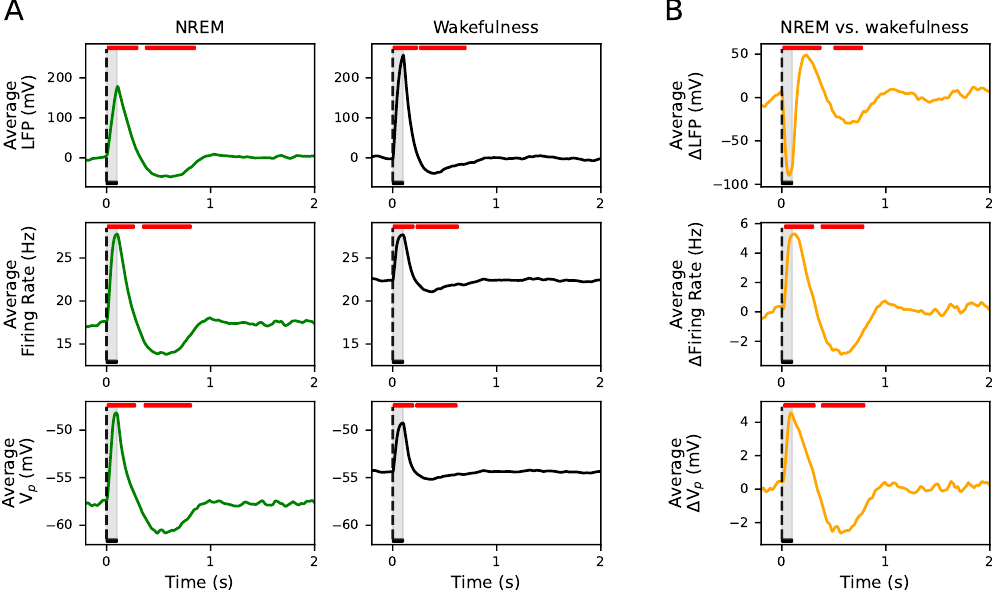
Figure 3. Evoked response in the one-cortical-column model. ( A ) Average LFP, firing rate and V p across 500 simulations for NREM sleep (left column) and wakefulness (right column). Red horizontal bars show the location and length of significant t-cluster statistics when comparing the poststimulus versus the prestimulus intervals. In all signals, responses to the external stimulus consist of one positive and one negative significant deflection. The positive ( p < 0.0006) and negative ( p < 0.001) deflections are significant in NREM and wakefulness. ( B ) Average difference ∆ LFP, ∆ firing rate and ∆ V p between NREM sleep and wakefulness across 500 simulations. Red horizontal bars show the location and length of significant t-cluster statistics when comparing the poststimulus intervals during NREM sleep with wakefulness. The positive ( p < 0.0005) and negative ( p < 0.001) deflections in all signals are significant. The amplitude of both deflections are higher in NREM sleep than in wakefulness in the firing rate and V p . The opposite happens in the LFP signal. In all cases, the dashed vertical line, aligned at zero, indicates stimulus ξ onset. Stimulus duration is represented by a black horizontal line and light gray